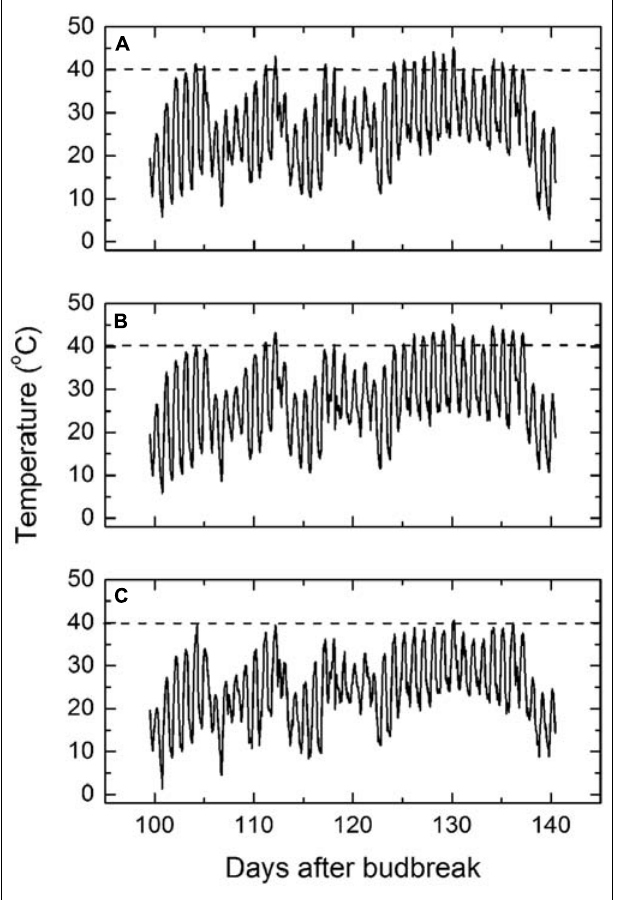
FIGURE 2 | (A–C) Mean daily maximum air temperatures (A) , exposed canopy temperatures (B), and protected canopy temperatures (C) from January 1, 2009 to February 10, 2009.The dotted line indicates the 40 ◦ C temperature to indicate when the temperatures exceeded this